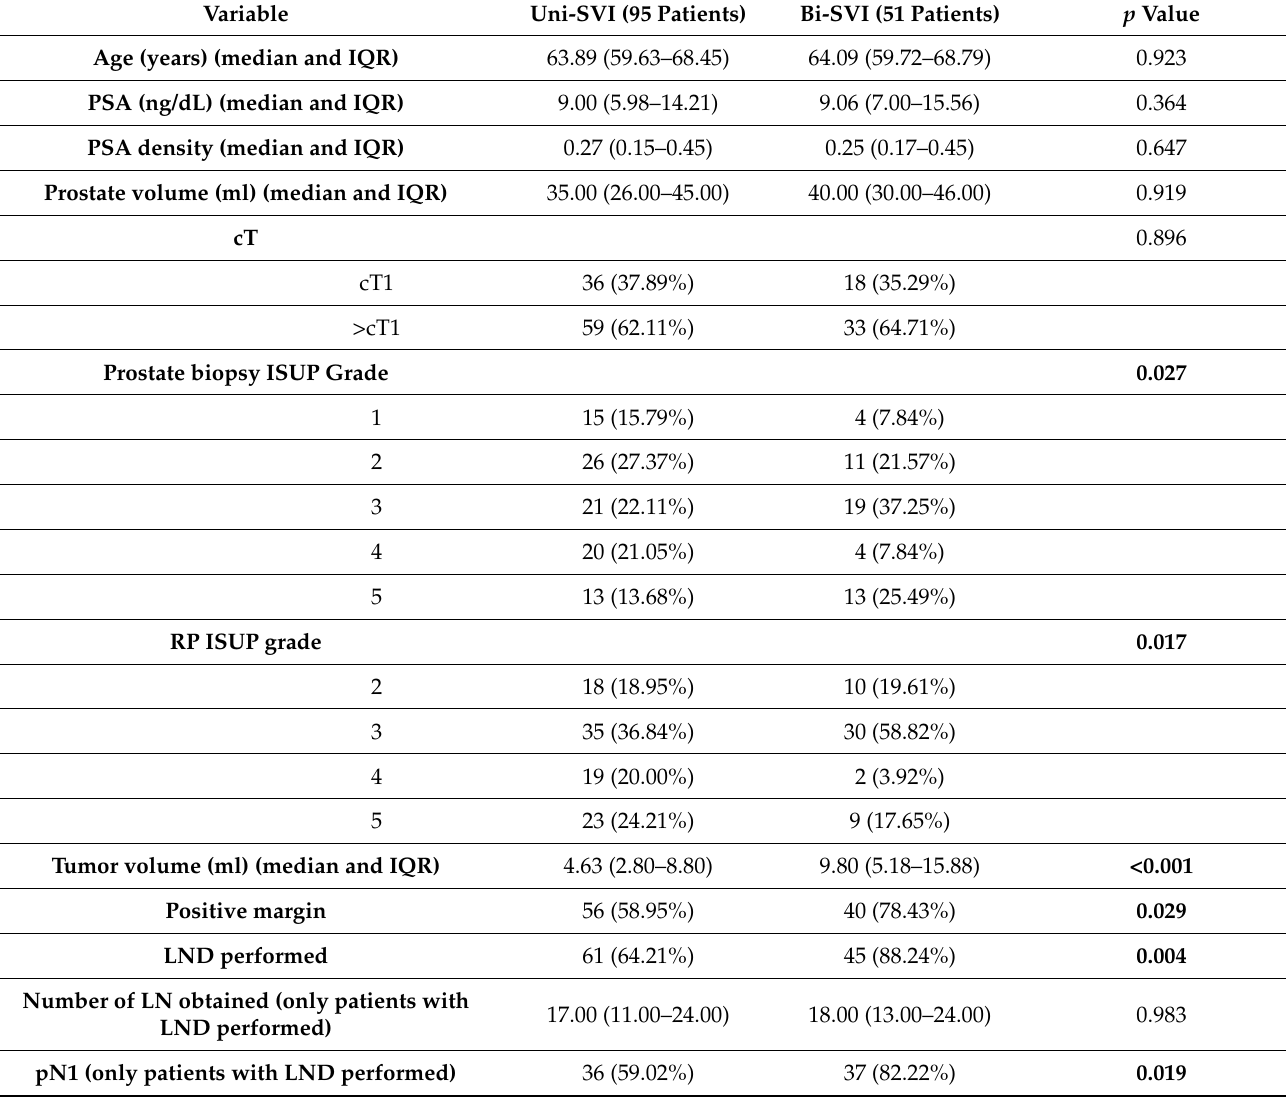
Table 1. Patient and RP characteristics sorted by uni-SVI or bi-SVI.